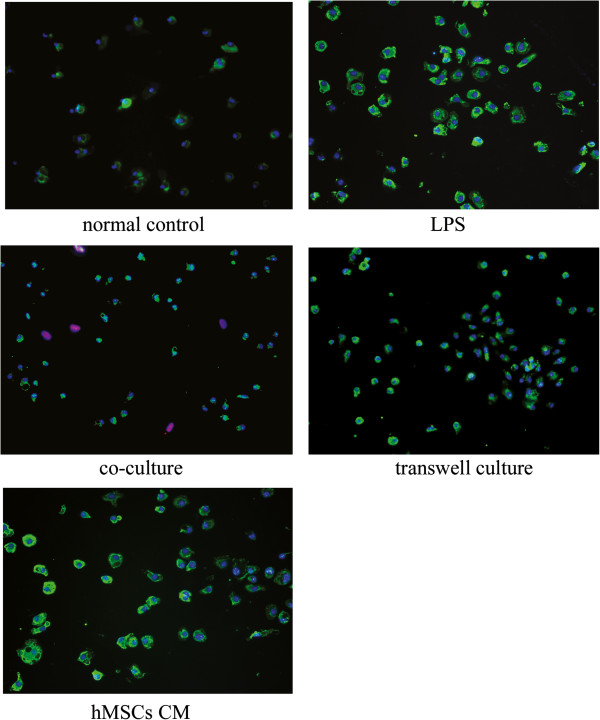
Effects of human marrow stromal cells on lipopolysaccharide-induced activation of microglia. Microglia were stimulated with 1 mg/μl lipopolysaccharide (LPS), and cultures were treated with human marrow stromal cells (hMSCs) in co-cultures and transwell cultures, and hMSC conditioned medium (CM) (400× magnifications). Cells were fixed after 12 hours of stimulation with LPS. Microglial cells were immunostained with an antibody against the F4/80 antigen, and hMSCs were stained with anti-HuNu antibody. In normal control cultures, the majority of microglial cells were small and round. Upon stimulation with LPS, most of the microglial cells showed an enlarged shape. MSCs in co-cultures and transwell cultures dramatically inhibited microglial activation, whereas hMSC CM has no significant effect on the microglial activation.